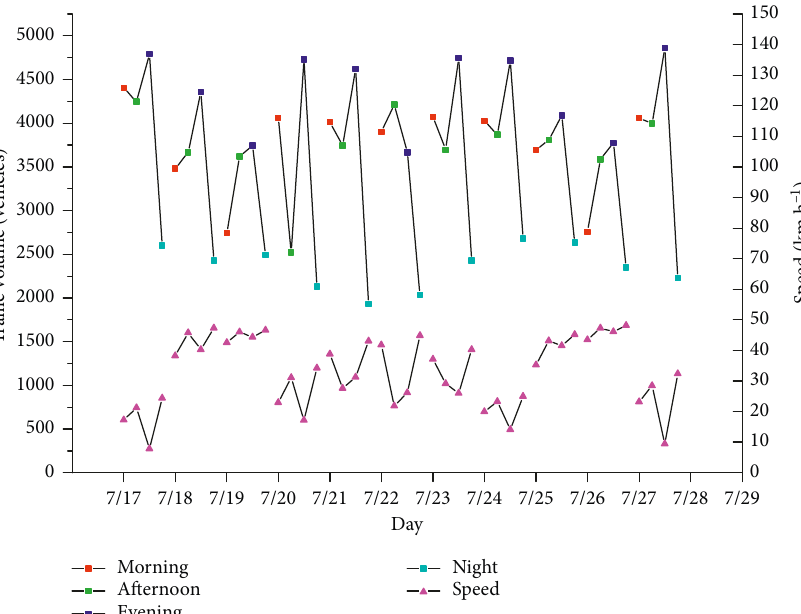
Figure 2: Diurnal variations in traffic volume and speed during the sampling period. Left axes show the number of vehicles during the morning transit (07:00–10:00), afternoon period (12:00–15:00), evening transit (17:00–20:00), and night period (22:00–24:00) from July 17 to July 27, 2015. The right axes show the corresponding average speed of the total